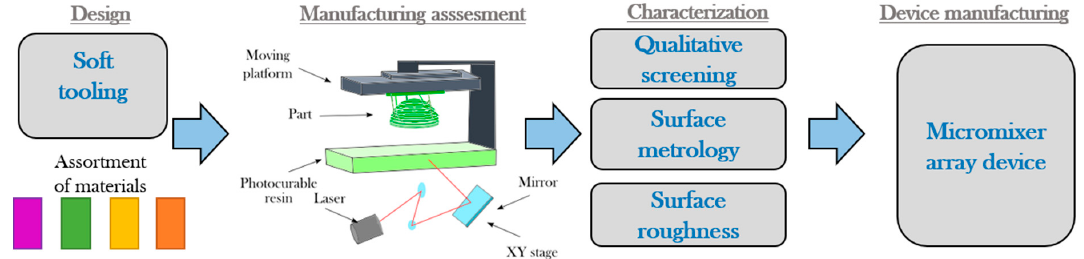
Figure 1. Steps for the screening of soft tooling based on stereolithography.